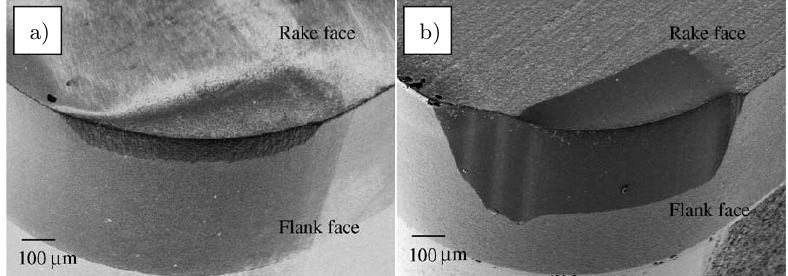
Figure 1. Comparison of tool wear ( a ) PCD-tipped and ( b ) IZ900 CBN-tipped tool according to